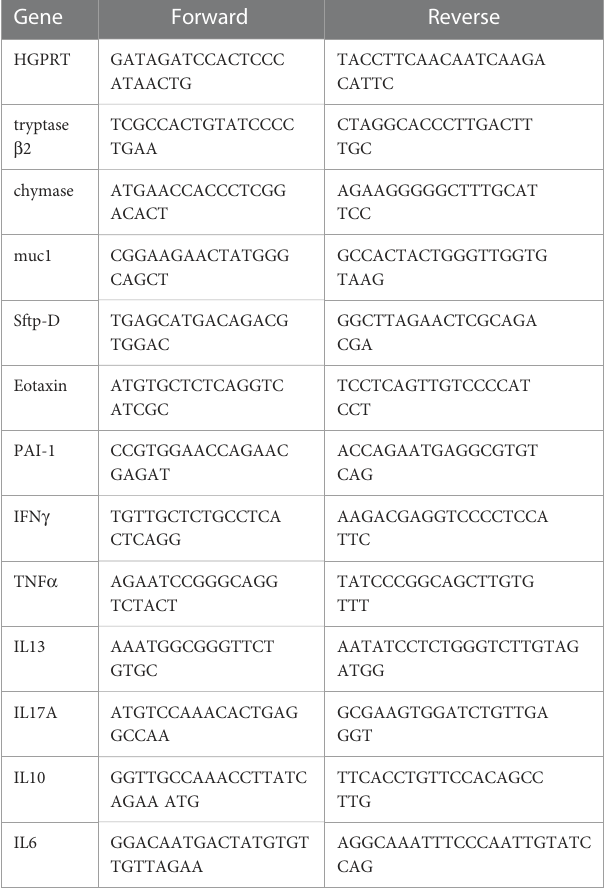
TABLE 1 Mouse qPCR